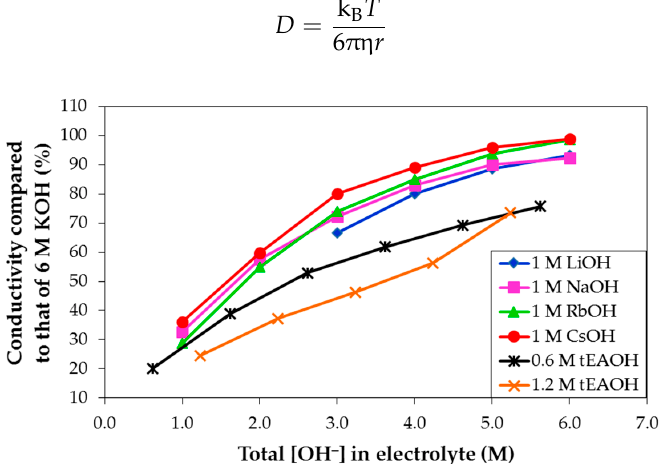
Figure 8. Plot of conductivities normalized to that of 6 M KOH aqueous solution vs. the total OH − concentration in solution for various hydroxide aqueous solutions. The KOH concentration is the difference between the total OH − concentration and additive concentration. As the total OH − concentration increases, the electrolyte conductivity increases. Also, at any fixed KOH concentration, the electrolyte conductivity increases in the order of tetraethylammonium hydroxide (tEAOH) < LiOH < NaOH < RbOH < CsOH addition.